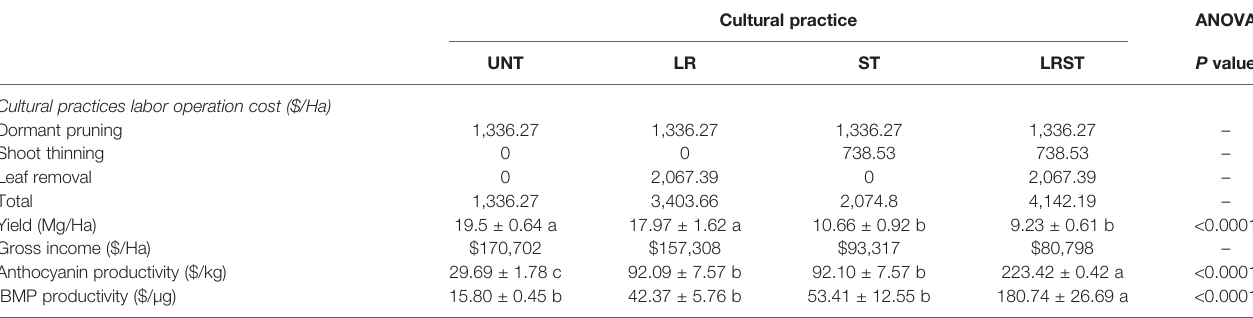
TABLE 4 | Cost estimates on labor operations costs of canopy management practices and cost to produce one unit of anthocyanin and IBMP of Cabernet Sauvignon grapevine subjected to untreated control (UNT), leaf removal (LR), shoot thinning (ST), and a combination of both (LRST) in Oakville, CA in 2019 (Kultural et al., 2020).